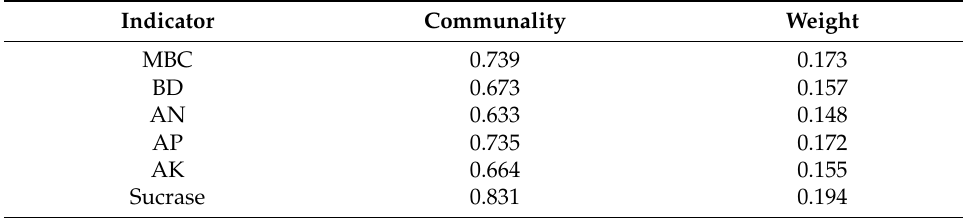
Table 7. Communality and weight of soil quality indicators in